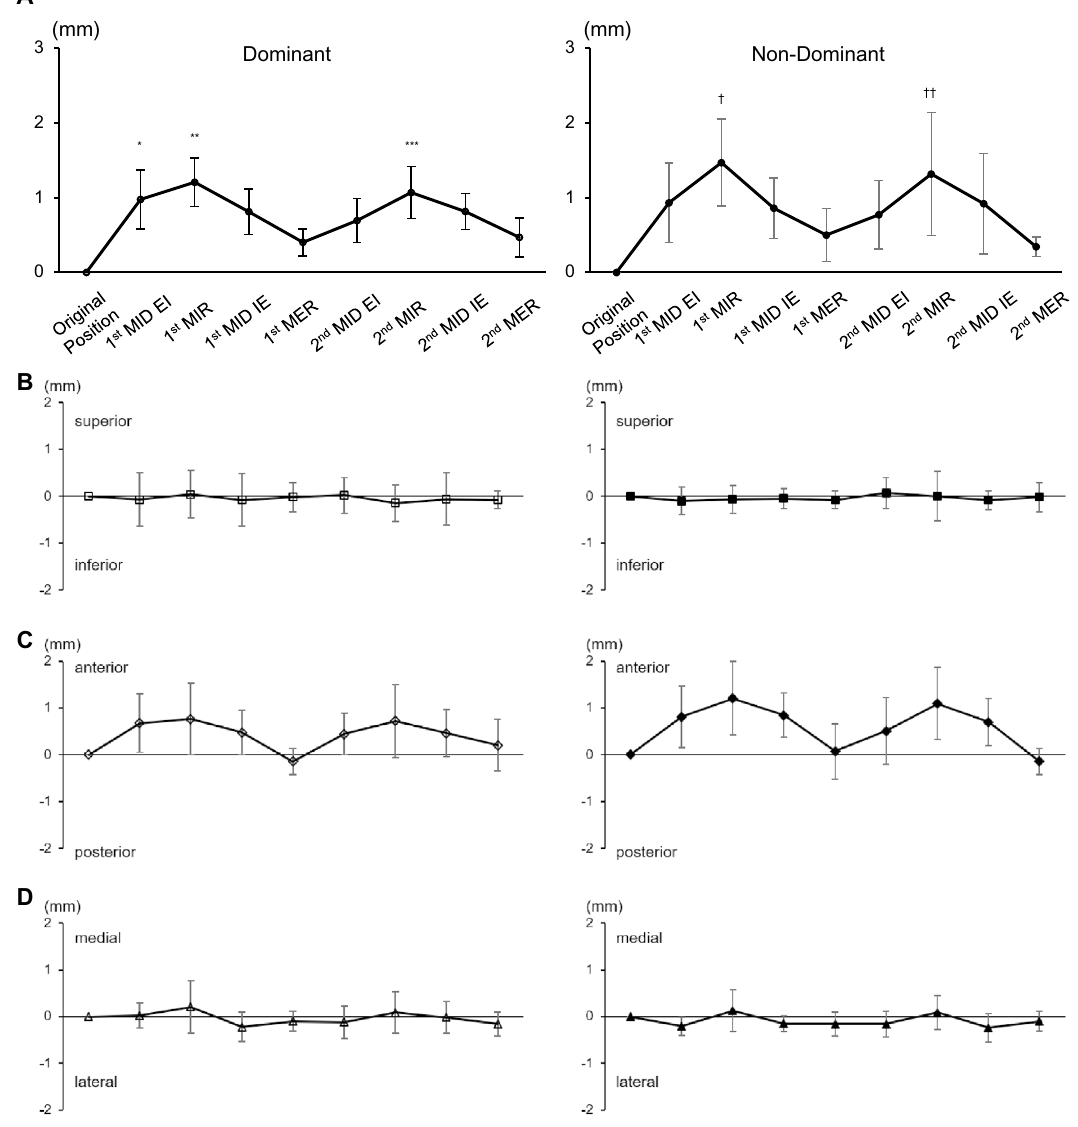
Figure 5. Distance of the center of humeral head from the original position to all other positions. ( A ) Absolute value of dominant shoulder and non-dominant shoulder. ( B ) Superior/inferior directions, ( C ) anterior/posterior directions, ( D ) medial/lateral directions. MER, maximum external rotation; MIR, maximum internal rotation; MID EI, midpoint from MER to MIR; MID IE, midpoint from MIR to MER. *P = 0.0141 vs 1st MER,